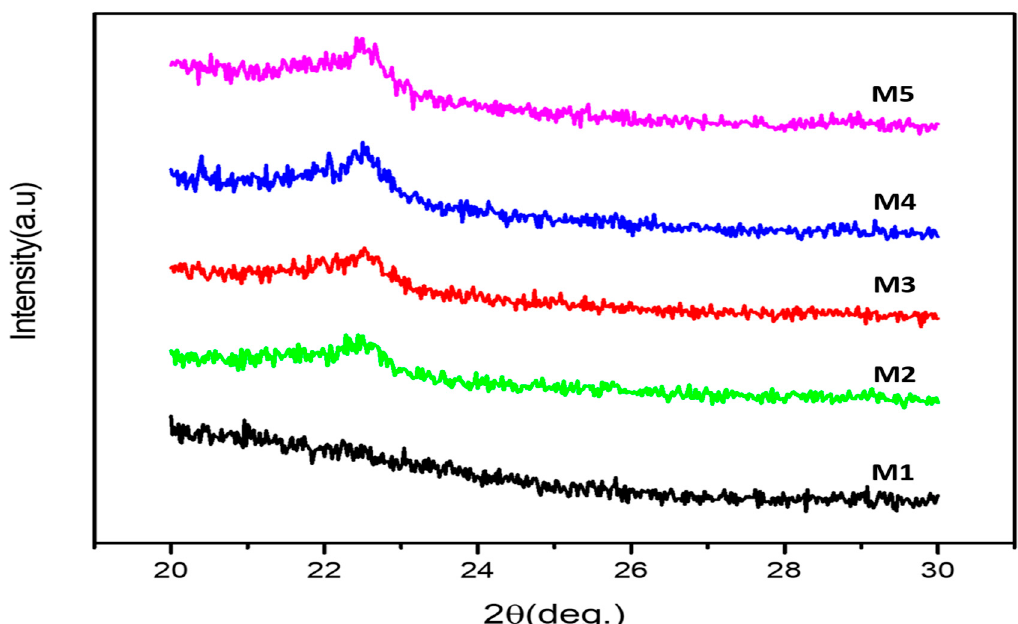
Figure 5. XRD of PLA, PLA-PBS, and PLA-PBS-MCC composite films.